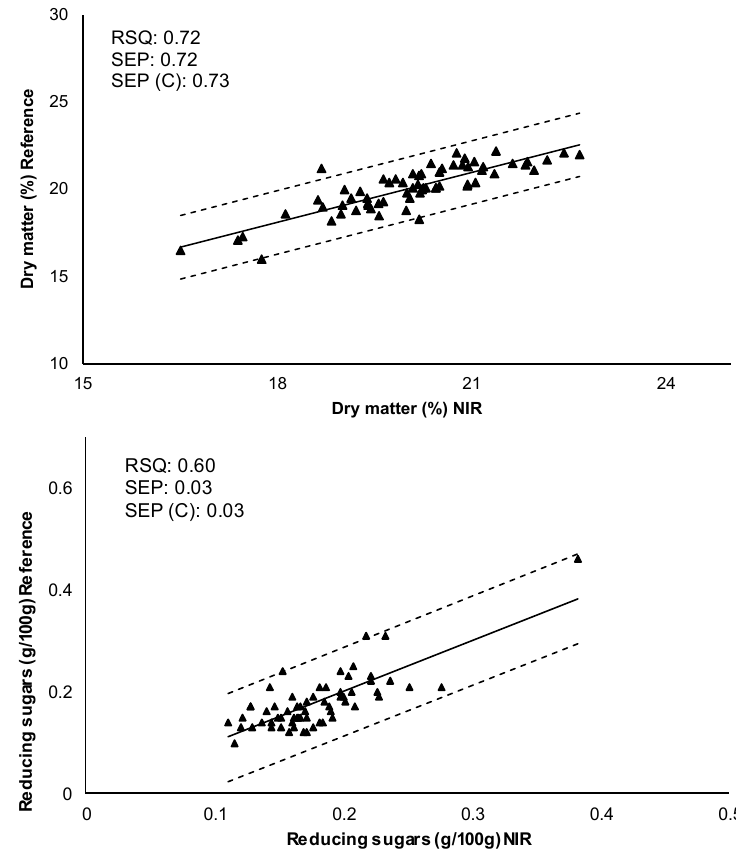
Figure 3. Internal validation. Comparison of reference values with predicted values by the NIRS model for each quality parameter. RSQ: Multiple correlation coefficient; SEP: Standard error of prediction; SEP (C): Standard error of prediction corrected by BIAS. Table 3. External validation (19 samples) of potato quality parameters with the results of the NIR